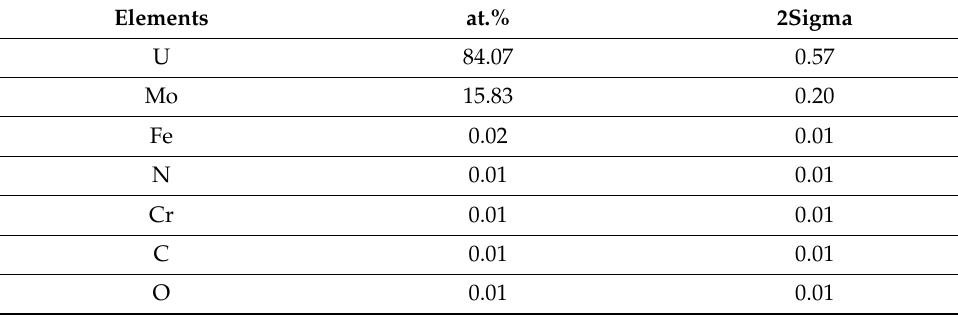
Table 1. Measured composition from fresh U-7 wt.% Mo (15.8 at.%